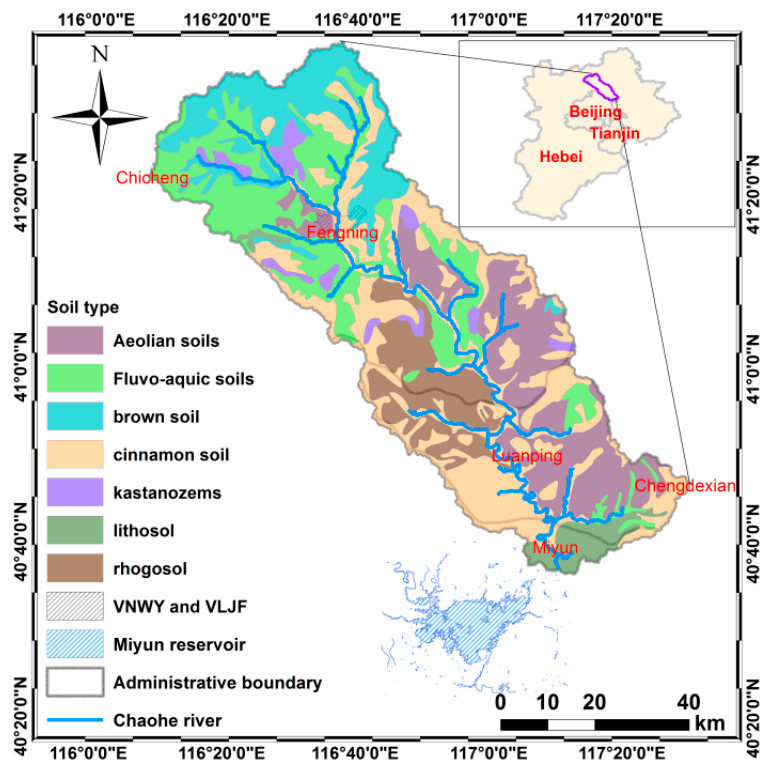
Figure 1. Location of the typical farms and study area with soil type.